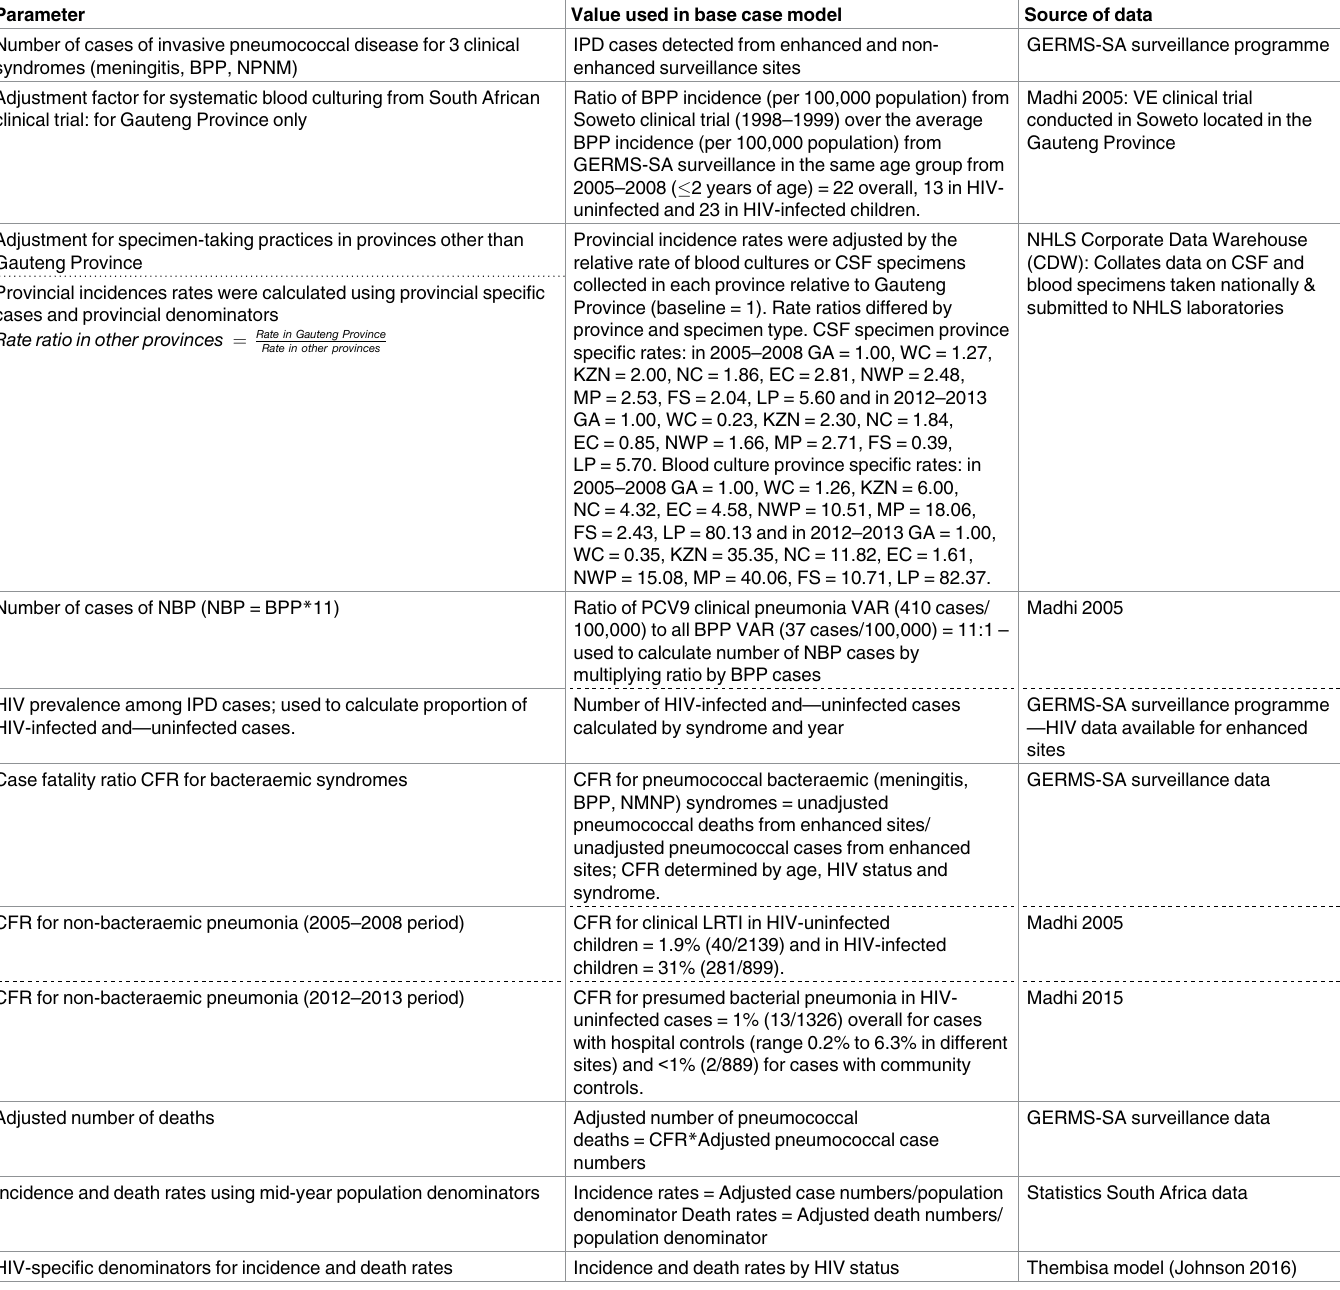
Table 1. Parameters used in base case model to estimatetotal number of cases, incidence and mortality rates for severepneumococcal disease among children aged < 5 years in South